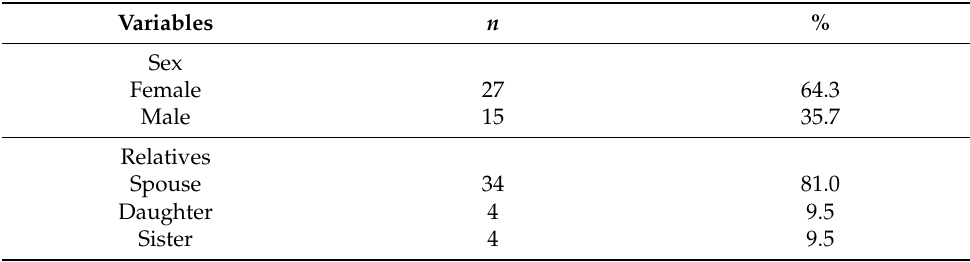
Table 2. The caregiver’s characteristics ( n =